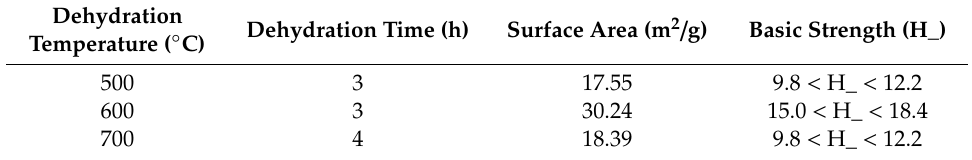
Table 3. Surface area and basic strength of the obtained CaO / PMFA-900 / 3 h